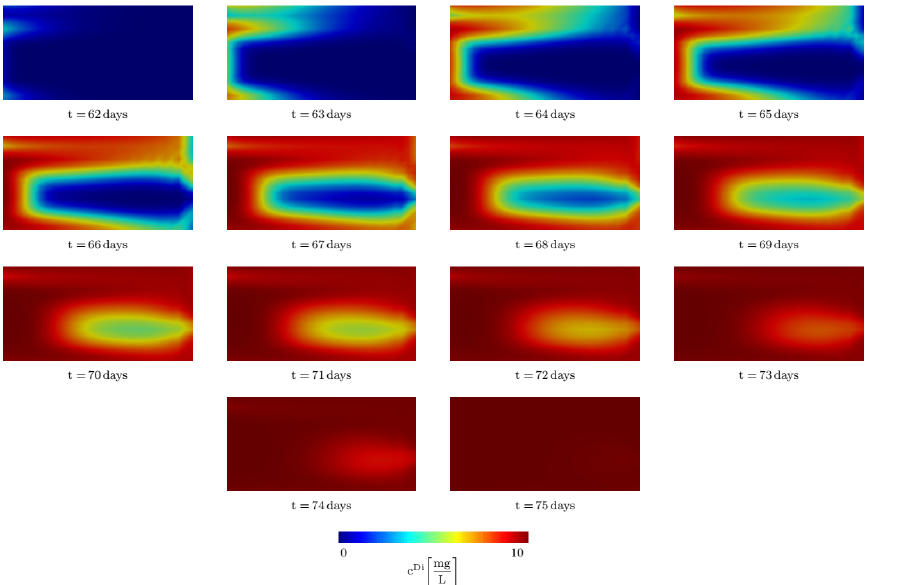
Figure 10. The distribution of the contaminant concentration in the area located between (85,21) and (90,25) at different times.